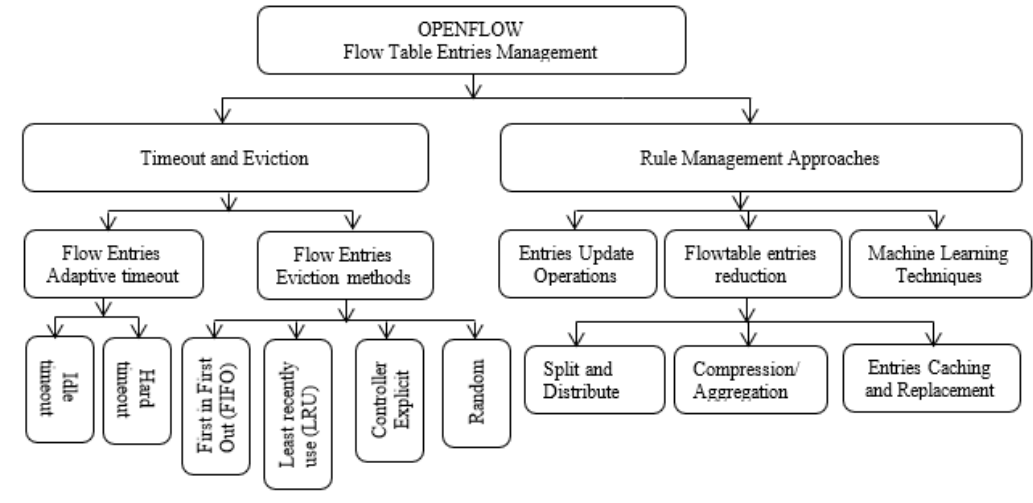
Figure 7. Taxonomy of flow entries management.